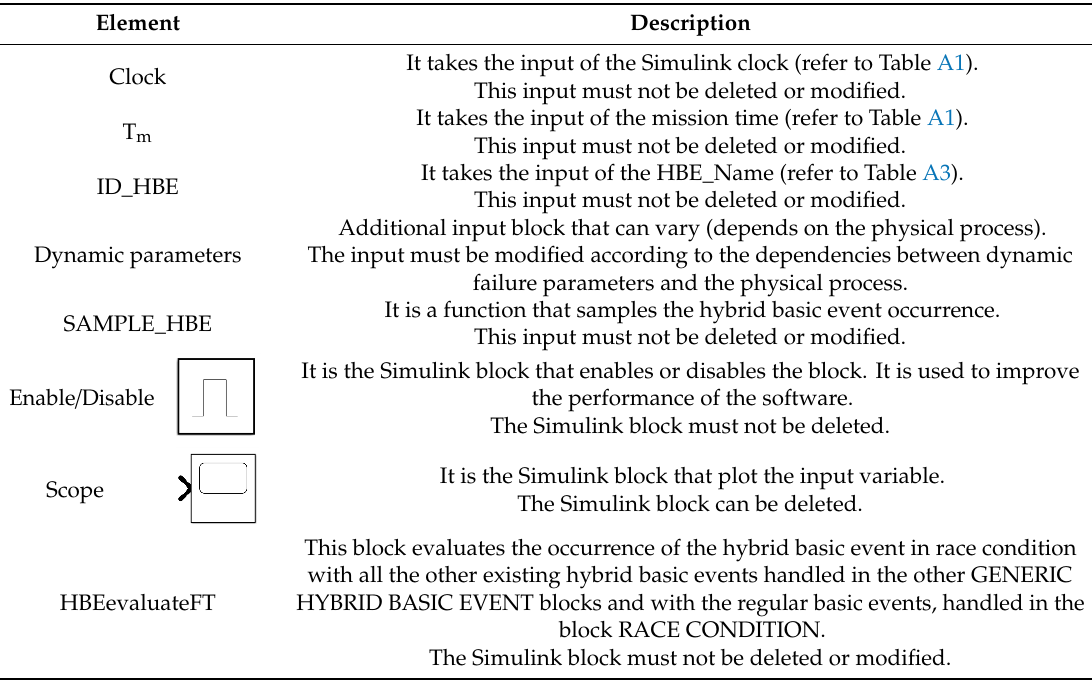
Table A4. Marking of the components of the HBE Simulink block.